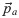
Simulation of MT dynamics on the rectangular parallelepiped surface.A Schematic representation of a rectangular parallelepiped and the symmetry direction p→a,p→b and p→c parallel to the edges a, b and c respectively (left panel). MTs were simulated by considering three different regulatory effects in the dynamics of MT: (A) default shape, which resulted in two clusters (cluster 1: ≈ 52% [519/991] around p→a, cluster 2: ≈ 46% [452/991] around p→b) of MT array orientation, (B) implementing edge-catastrophe, which resulted in two clusters (cluster 1: ≈ 28% [276/992] around p→b, cluster 2: ≈ 71% [706/992] around p→c), and (C) enhanced MT stabilization at a face of largest area, which resulted in two different clusters (cluster 1: ≈ 77% [762/995] around p→a, cluster 2: ≈ 19% [186/995] around p→c) of array orientations.